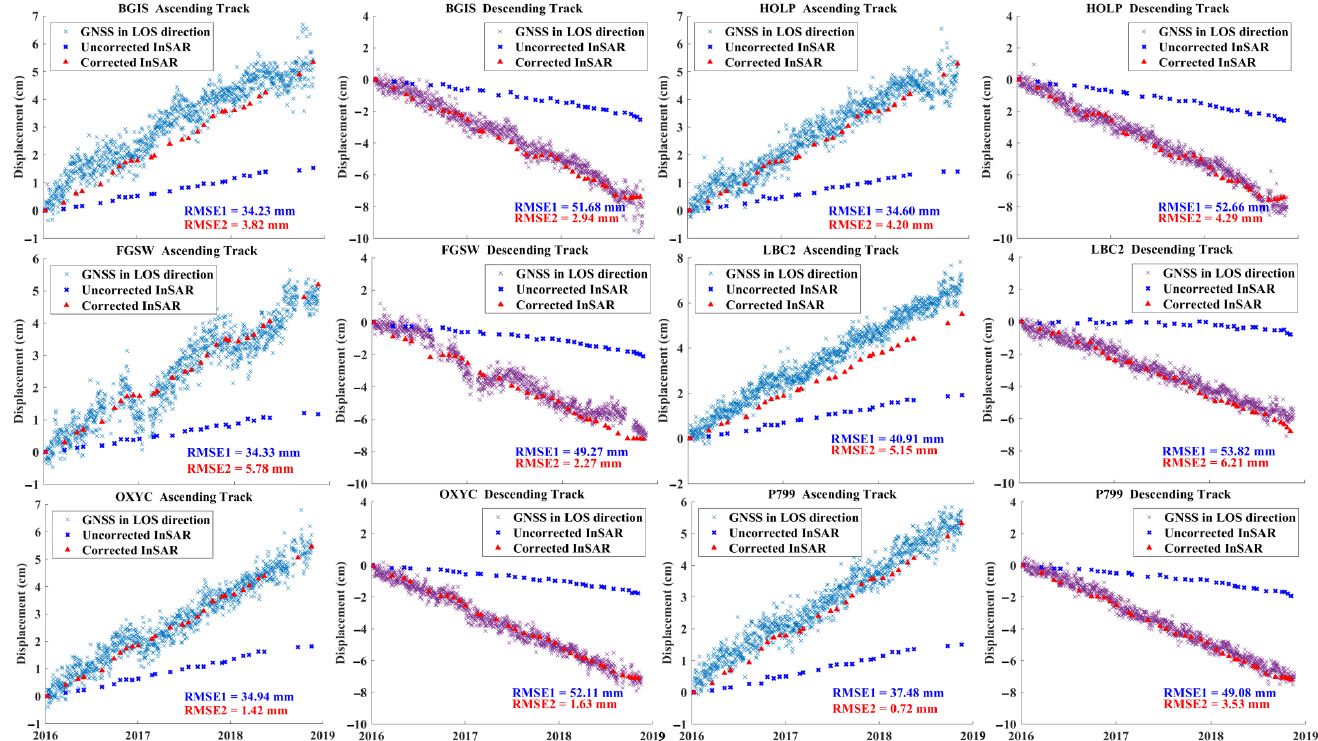
Figure 8. Comparison of the difference between GNSS and InSAR before and after the